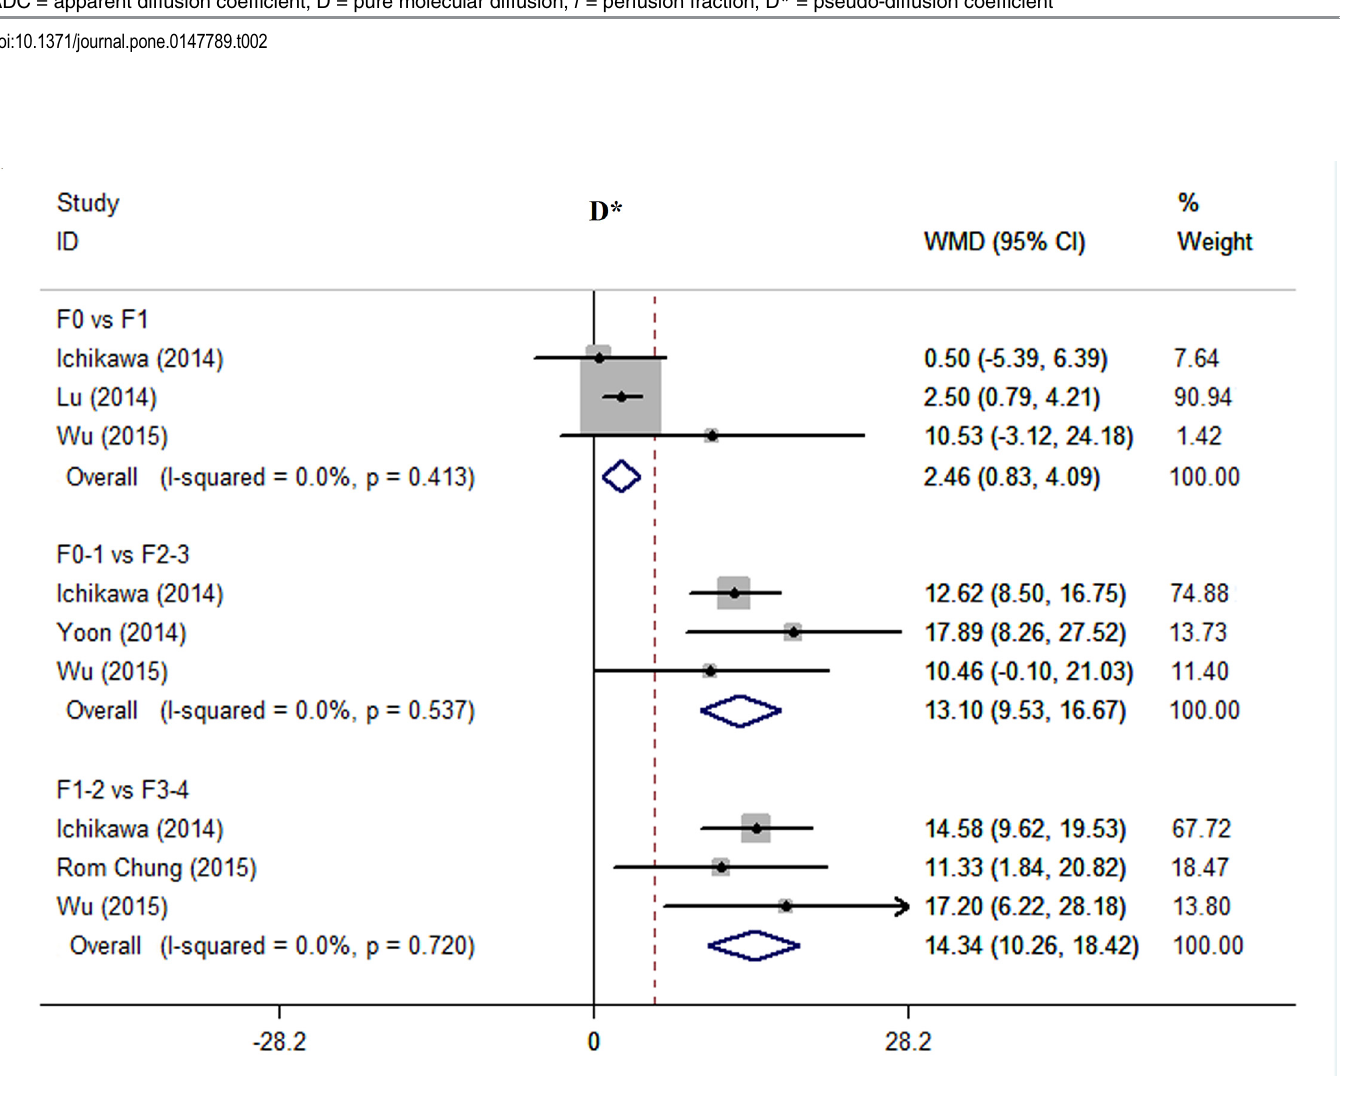
Fig 3. Comparing stage F0 with F1, F0-1 with F2-3, and F1-2 with F3-4 using D * . We used influence analysis to drop a study exerted excessive influence on the overall estimate and therefore to decrease the heterogeneity. Abbreviations: WMD = weighted mean difference; CI = confidence